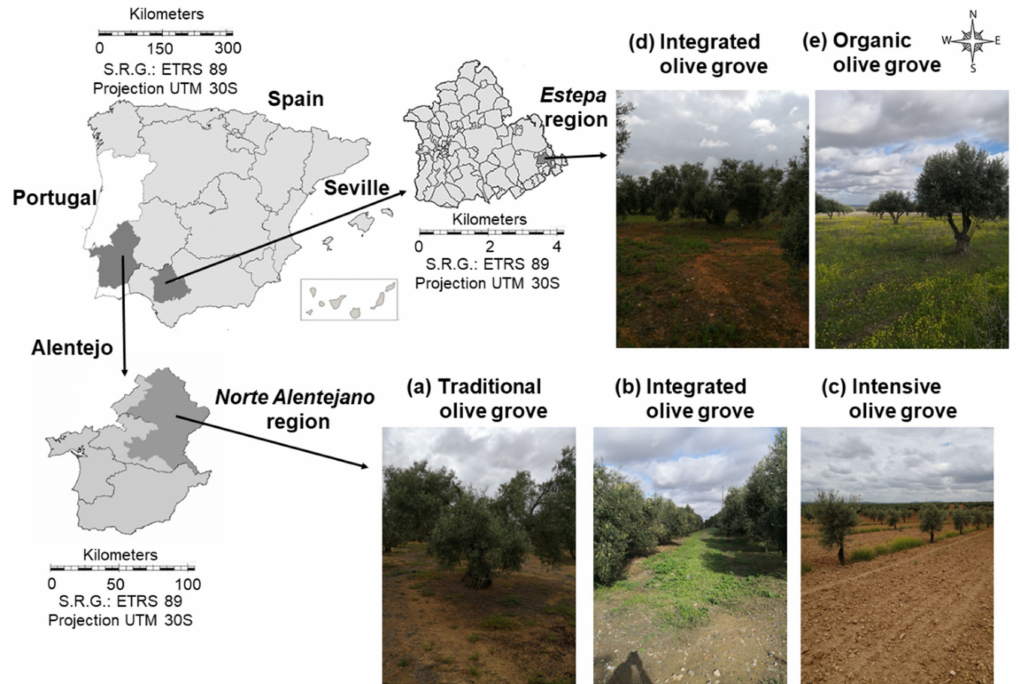
Figure 1. Geographical location of the Protected Designation of Origin (PDO) Norte Alentejano, including the olive management models: ( a ) traditional olive grove; ( b ) integrated olive grove; and ( c ) intensive olive grove. The PDO Estepa is also shown, where olive groves may be under integrated ( d ) or organic ( e )